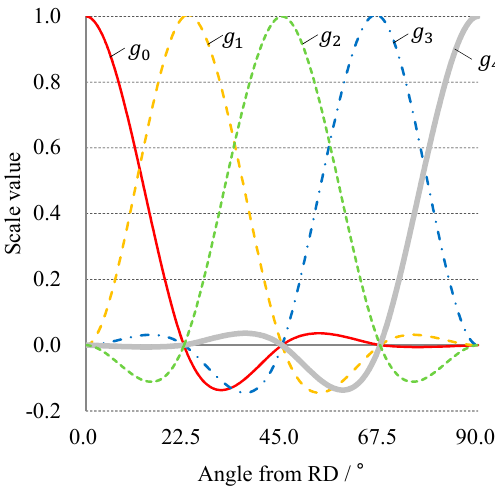
Figure 2. Spline basis function for interpolation.